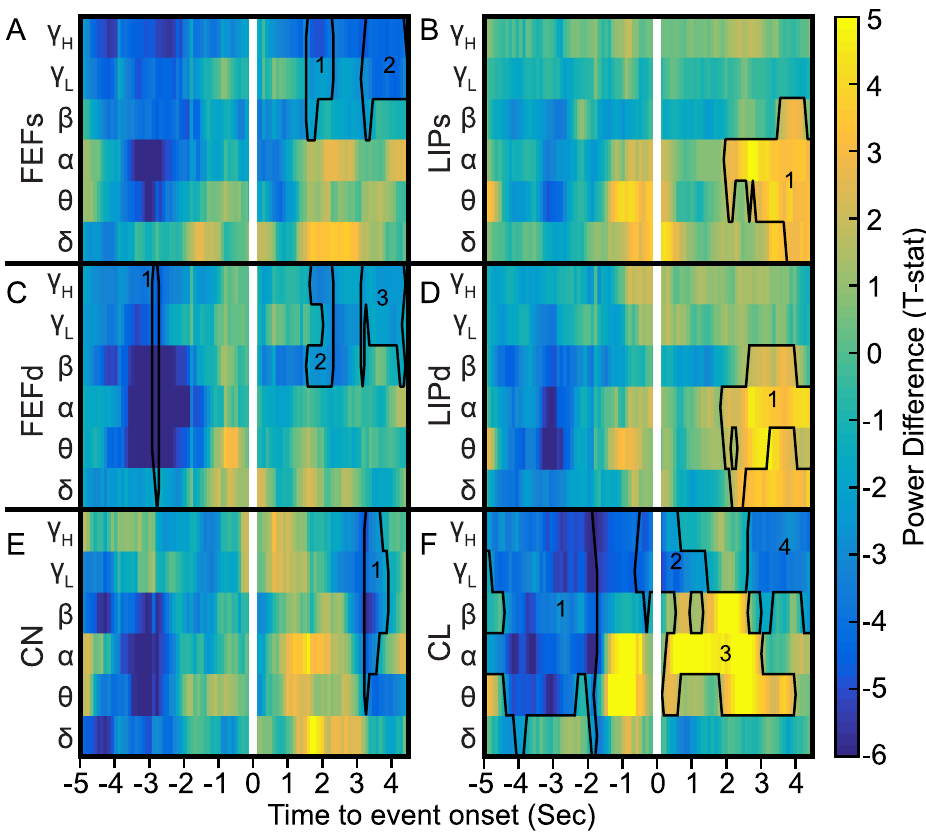
Fig 9. VPC is associated with increases in low-frequency power relative to control stares. A-F Spectrograms of power differences (VPC–control stare) for each frequency band across time aligned to event onset (white vertical line). Results include all recorded VPC and control stares for ( A ) superficial FEF, ( B ) superficial LIP, ( C ) deep FEF, ( D ) deep LIP, ( E ) CN, and ( F ) only the subset of events without thalamic DBS for CL. Significant clusters are outlined in black with numerical labels referenced in Table 1 for statistical details.